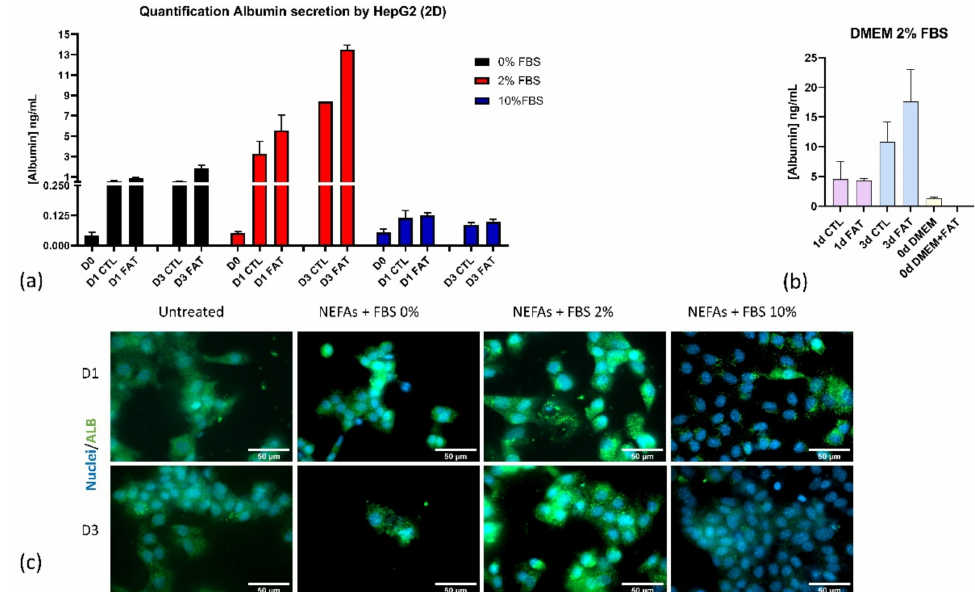
Figure 5. Comparison biodetection of albumin by nanoplasmonic biosensor and fluorescence assay. ( a ) Quantification of secreted albumin generated by 2D in vitro model of fatty hepatocytes treated with cell media at 0, 2, and 10% FBS during three days. ( b ) Evaluation of matrix e ff ect and fat supplement in the cell media with the detection of secreted albumin performed in cell media at 2% FBS. ( c ) Intracellular staining of albumin using immunochemistry